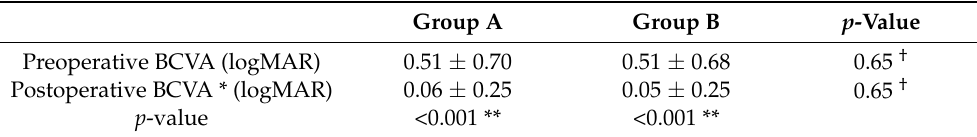
Table 4. Preoperative and postoperative best-corrected visual acuity in logMAR units. Group A Group B p -Value Preoperative BCVA (logMAR) 0.51 ± 0.70